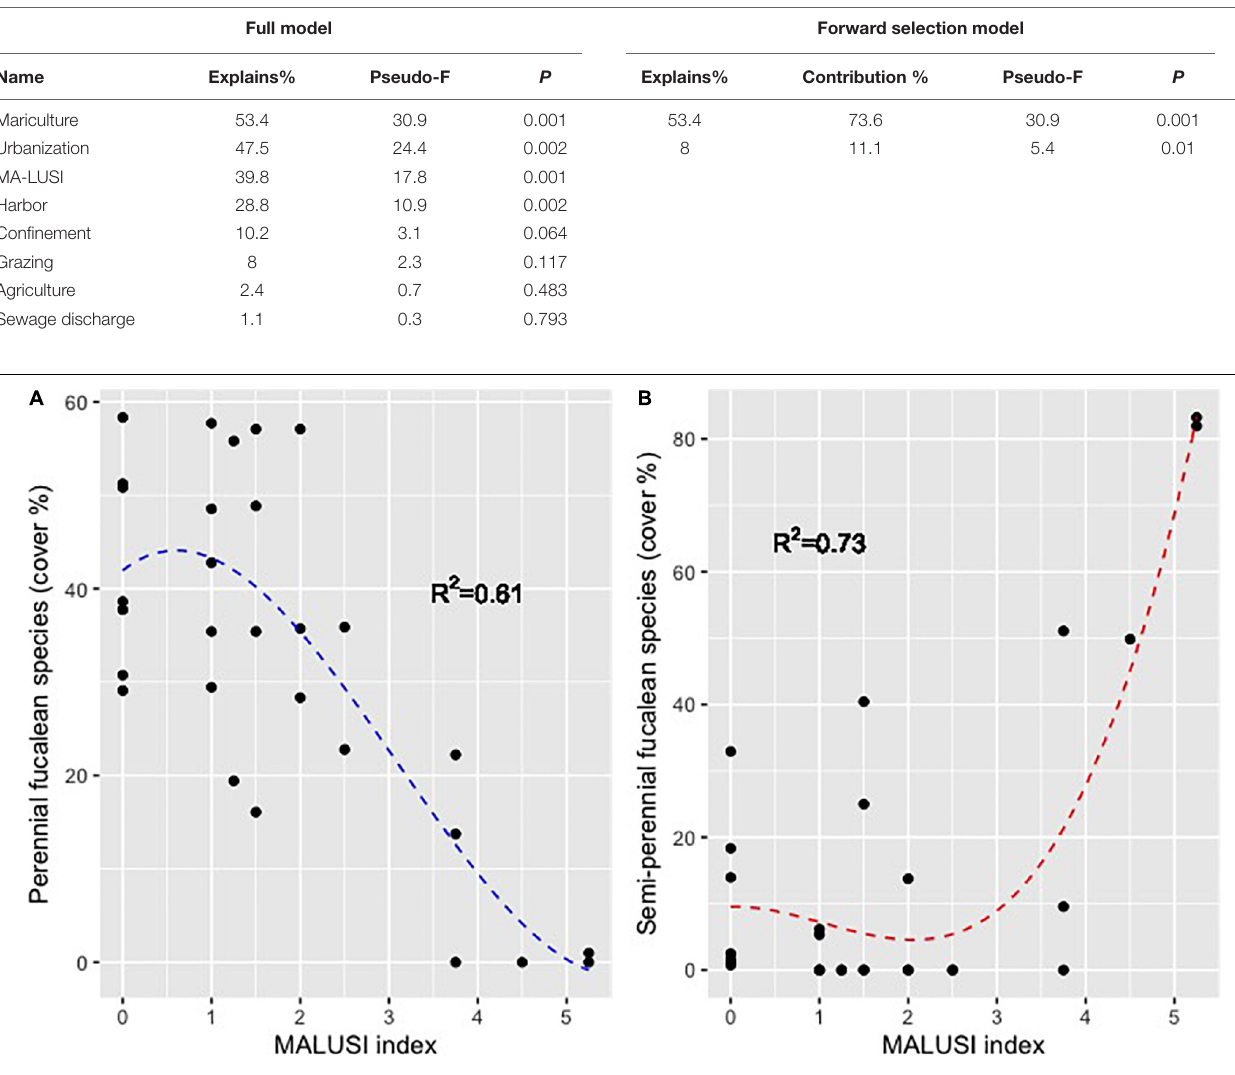
TABLE 3 | Simple term effect of explanatory variables of RDA full and forward selection models between the percentage cover of perennial fucalean seaweeds and semi-perennial C. compressa and C. compressa var. pustulata found in the sampled locations, and the main anthropogenic (urbanization, agriculture, mariculture, sewage discharge, harbour- related pollution) and natural (confinement, sea urchin grazing) stressors (for more information see Figure 6 ).